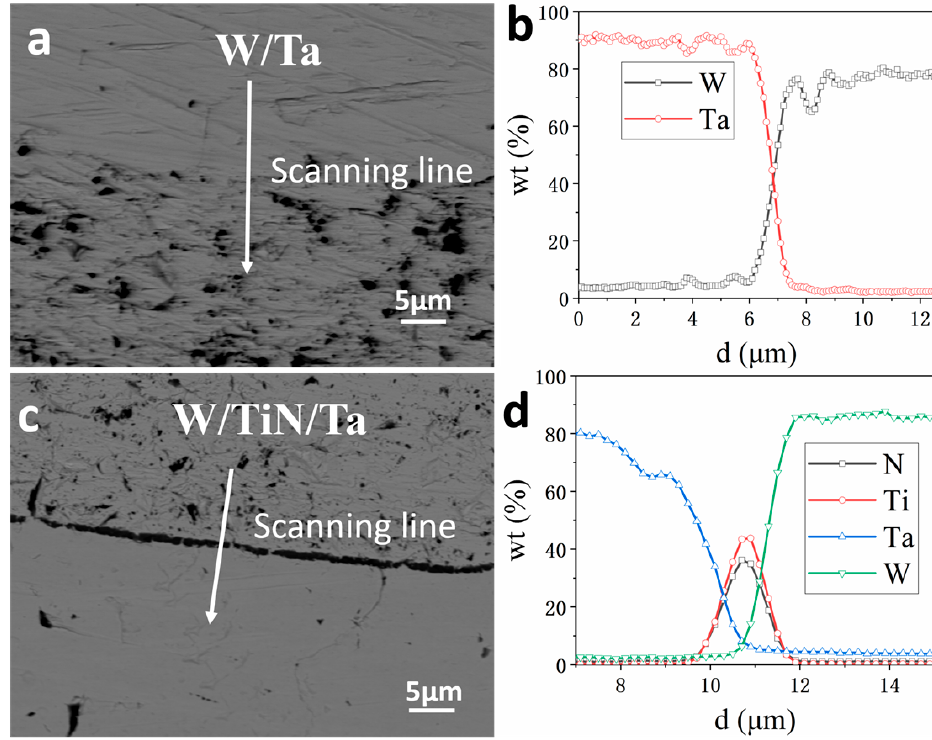
Figure 3. Element line-scan results of W/Ta and W/TiN/Ta-laminated composites joined at 1400 °C: ( a , b ) W/Ta, ( c , d ) W/TiN/Ta.